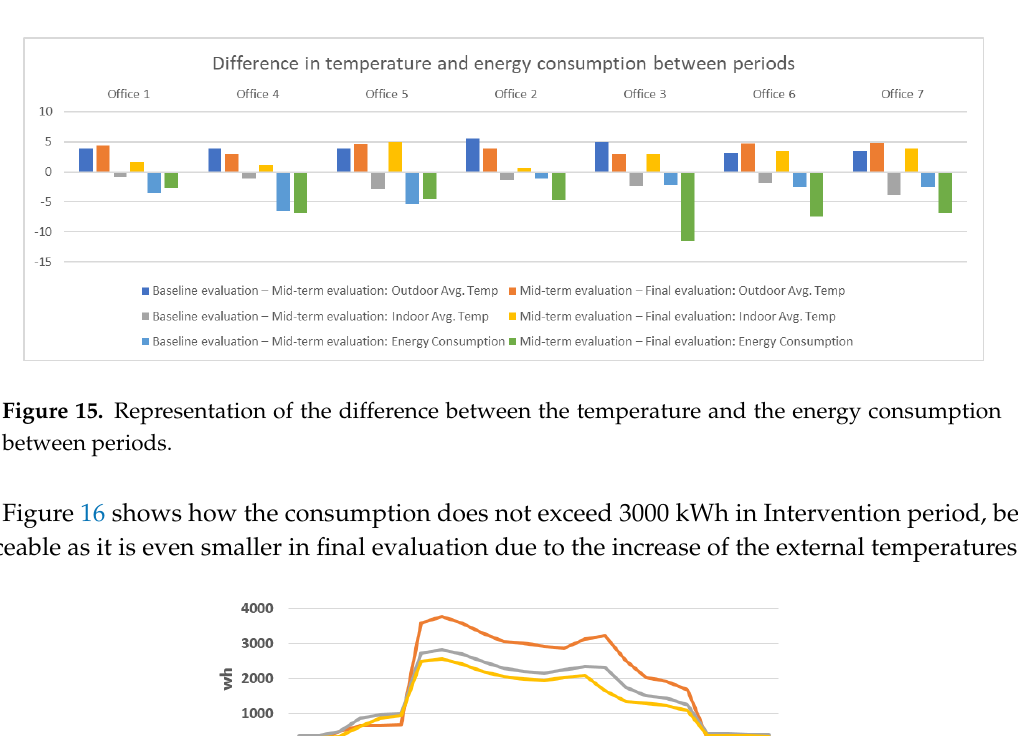
Figure 14. Energy consumption in office 4 of the first day of the mid-term evaluation.